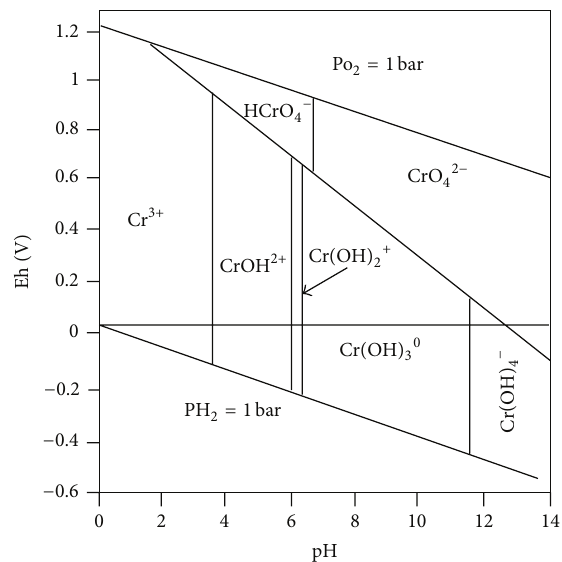
Figure 1: Redox potential (Eh)-pH diagram for Cr–O–H system